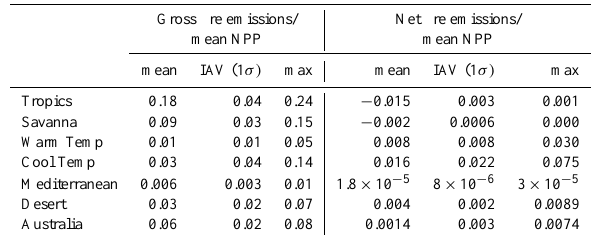
Table 2. Ratio of annual gross fire emissions and annual net fire emissions to mean NPP (1990–2011): mean ratio; IAV of ratio and maximum ratio for the 1997–2009 period.